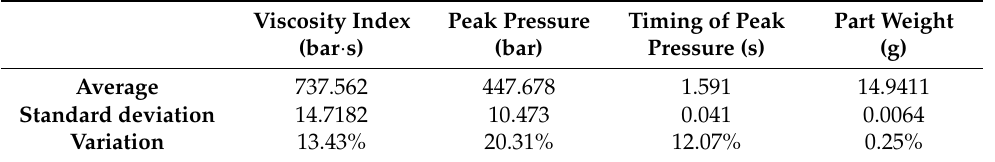
Figure 25. Performance comparison between using system and no system. Table 4. Analysis results of pressure curve characteristics and part weight without adaptive con- trol system.